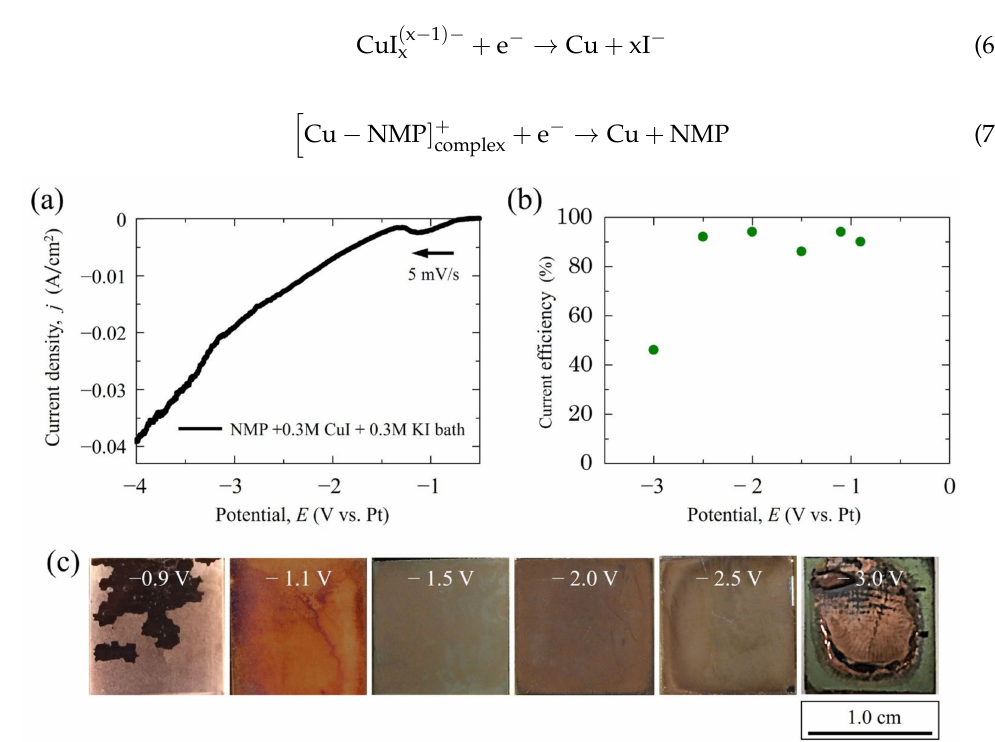
Figure 3. Electrodeposition behavior of Cu from NMP-KI-CuI bath: ( a ) Cathodic polarization curve, ( b ) current efficiency, and ( c ) photographs of Cu plating after constant potential electrolysis at respective